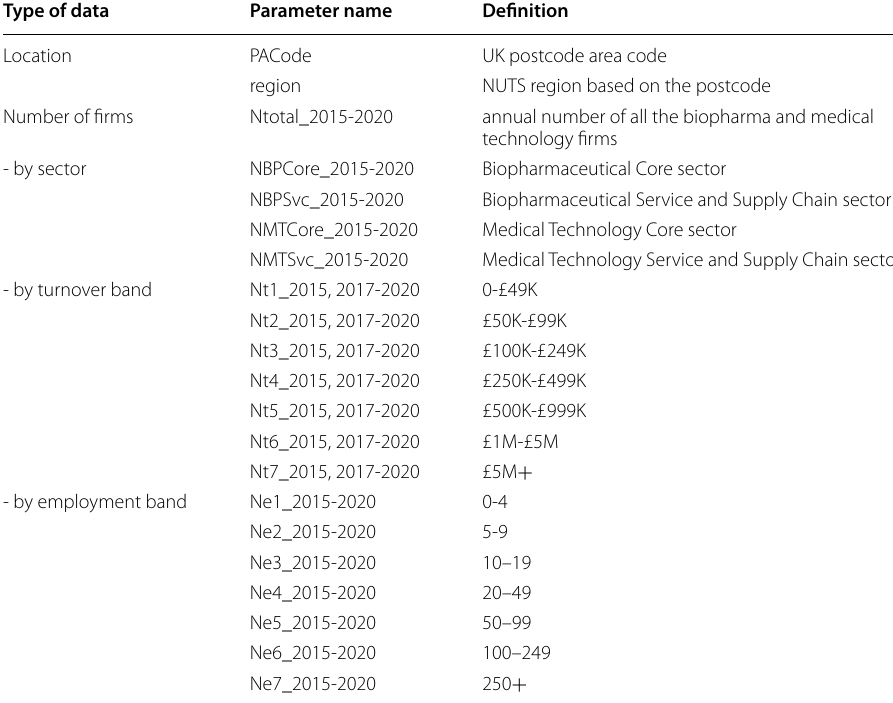
Table 1 Key parameters extracted from UK Bioscience and Health Technology Statistics raw data Type of